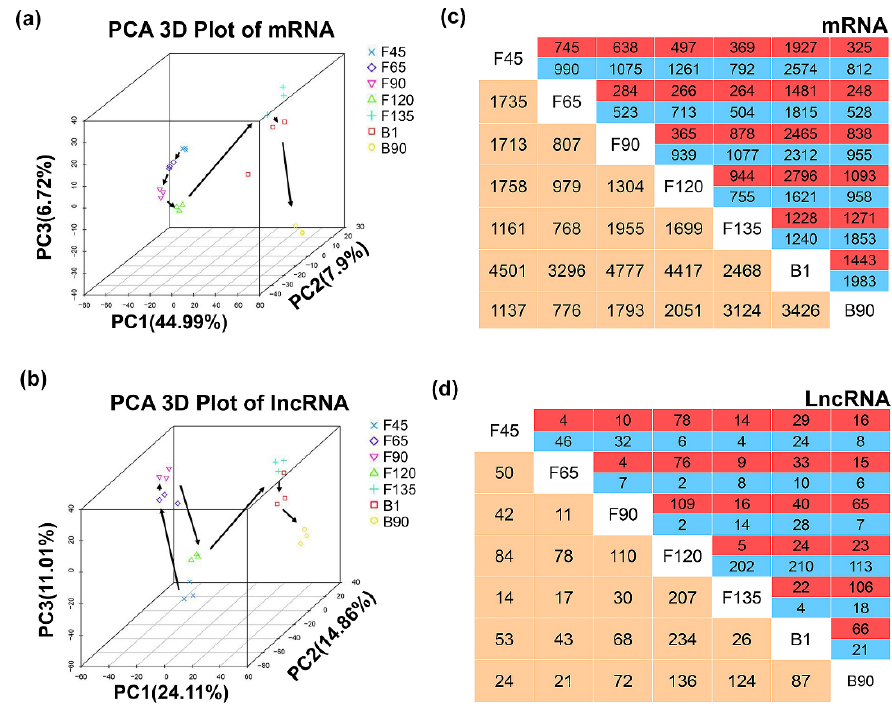
Figure 3. Expression patterns of lncRNAs and mRNAs during goat skeletal muscle development. ( a,b ) Principal component analysis (PCA) analysis of lncRNAs and mRNAs in 21 samples of goat skeletal muscle at seven different stages of development. The same color represents the same stage. The arrows indicate the direction of development between successive muscle stages. ( c,d ) Number of differentially expressed mRNAs (top) and lncRNAs (bottom) showing up- (red) or down- (blue) regulation during development. Yellow: number of total differential genes between two stages.